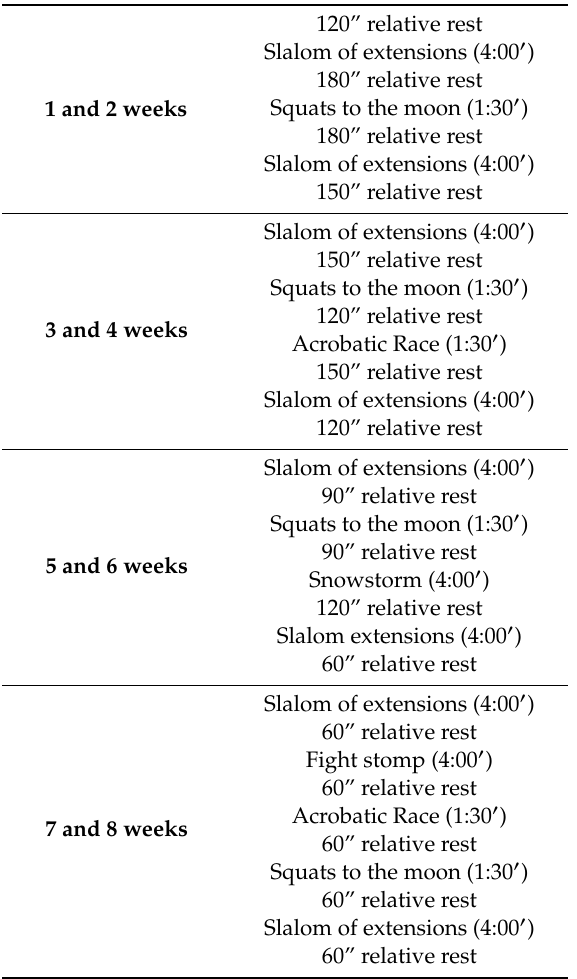
Table 1. Virtual reality protocol and video